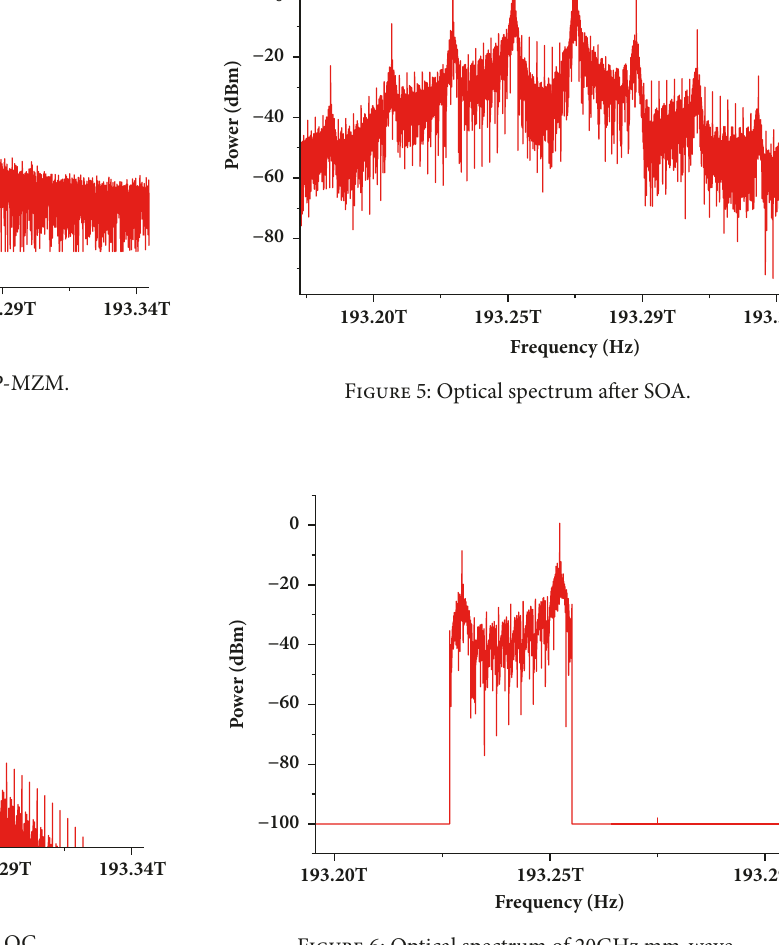
Figure 6: Optical spectrum of 20GHz